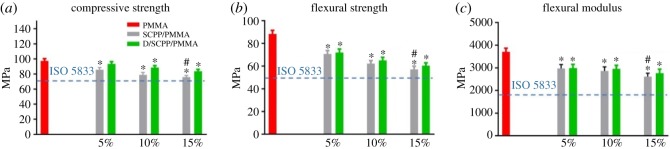
Mechanical properties of PMMA bone cement: (a) compressive strength, (b) flexural strength, (c) flexural modulus (*significant difference with PMMA group; # significant difference with 15% D/SCPP/PMMA group; p < 0.05).